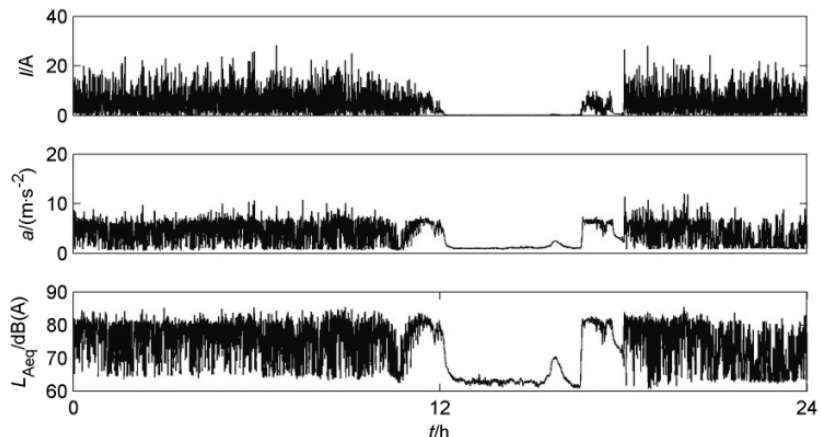
Figure 12. Vibration variation with direct current and sound pressure level of the power transformer.